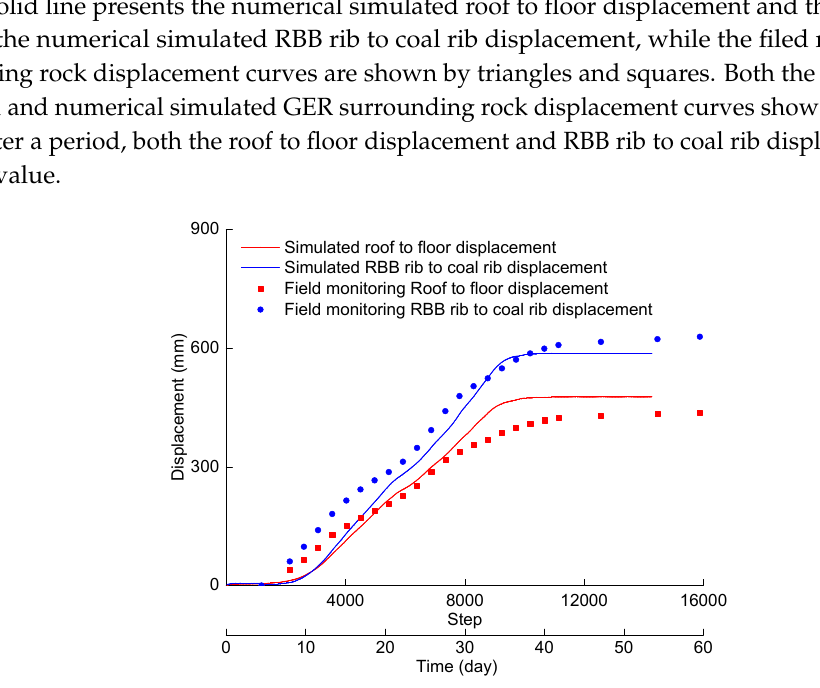
14 of 16 Figure 16. Monitoring results of the surrounding rock displacement.